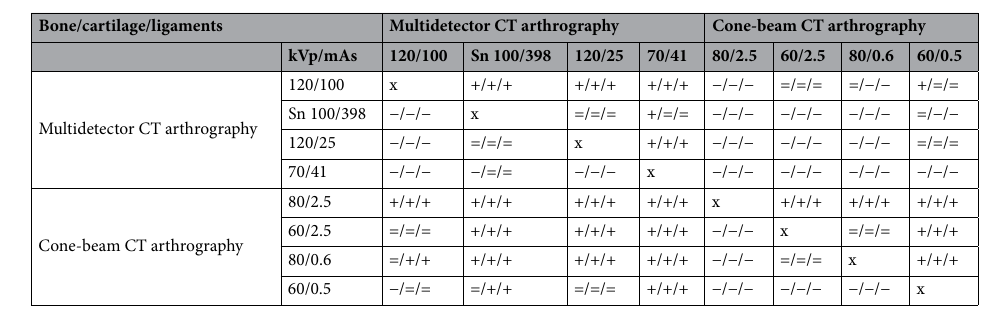
Table 3. Subjective image quality comparison. Mean image quality rank compared between scan protocols for bone/cartilage/ligaments with pairwise post-hoc analyses. kVp kilovoltage peak, mAs milliampere-seconds, Sn tin prefiltration. p values of pairwise post-hoc tests were Bonferroni-corrected for multiple comparisons. “ + ”: superior image quality; “−”: inferior image quality; “ = ”: no statistically significant difference in image quality.